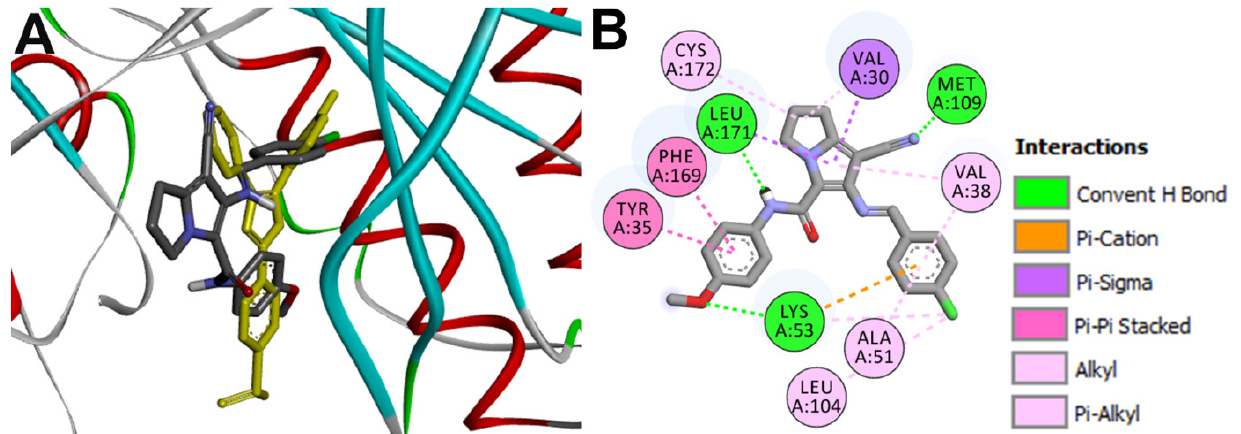
Figure 17. Binding mode of compound 16g (shown as sticks colored by element) into MAP p38 α (pdb: 3GCP): ( A ) 3D binding mode of compound 16g overlaid with the co-crystallized ligand, SB2 (yellow sticks); ( B ) 2D binding mode of compound 16g showing different types of interactions with amino acids in p38 α .